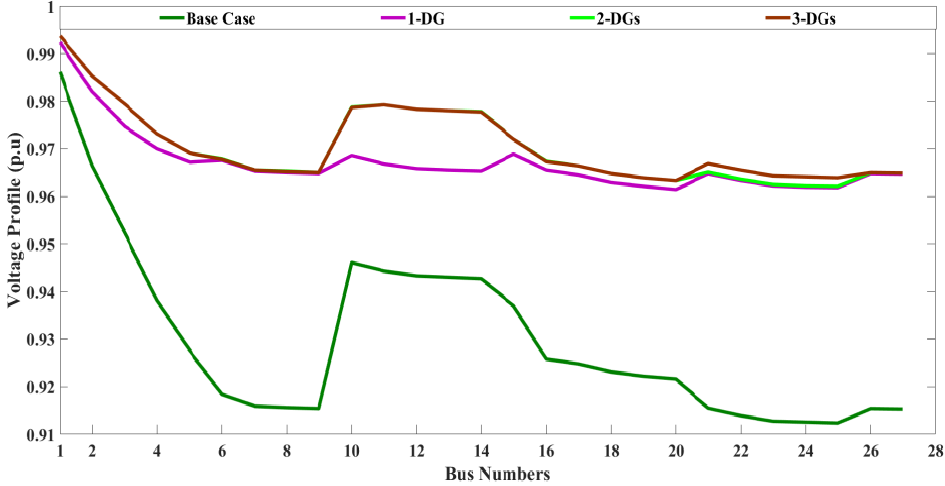
Figure 11. Voltage Profile for 28 Test System.